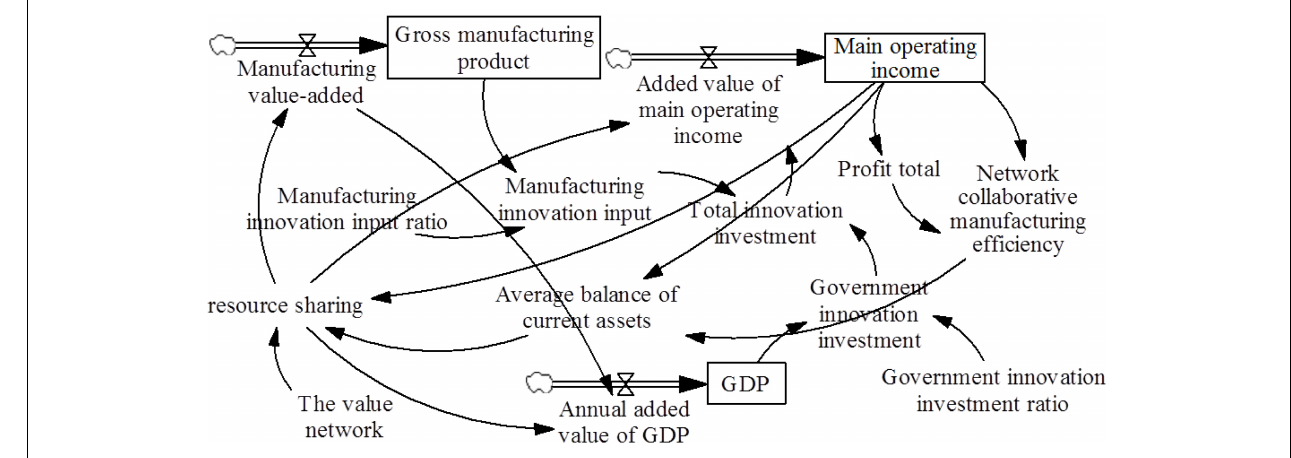
FIGURE 6 | Macro flow diagram of the manufacturing industry. TABLE 3 | Comparison of the real value and fitting